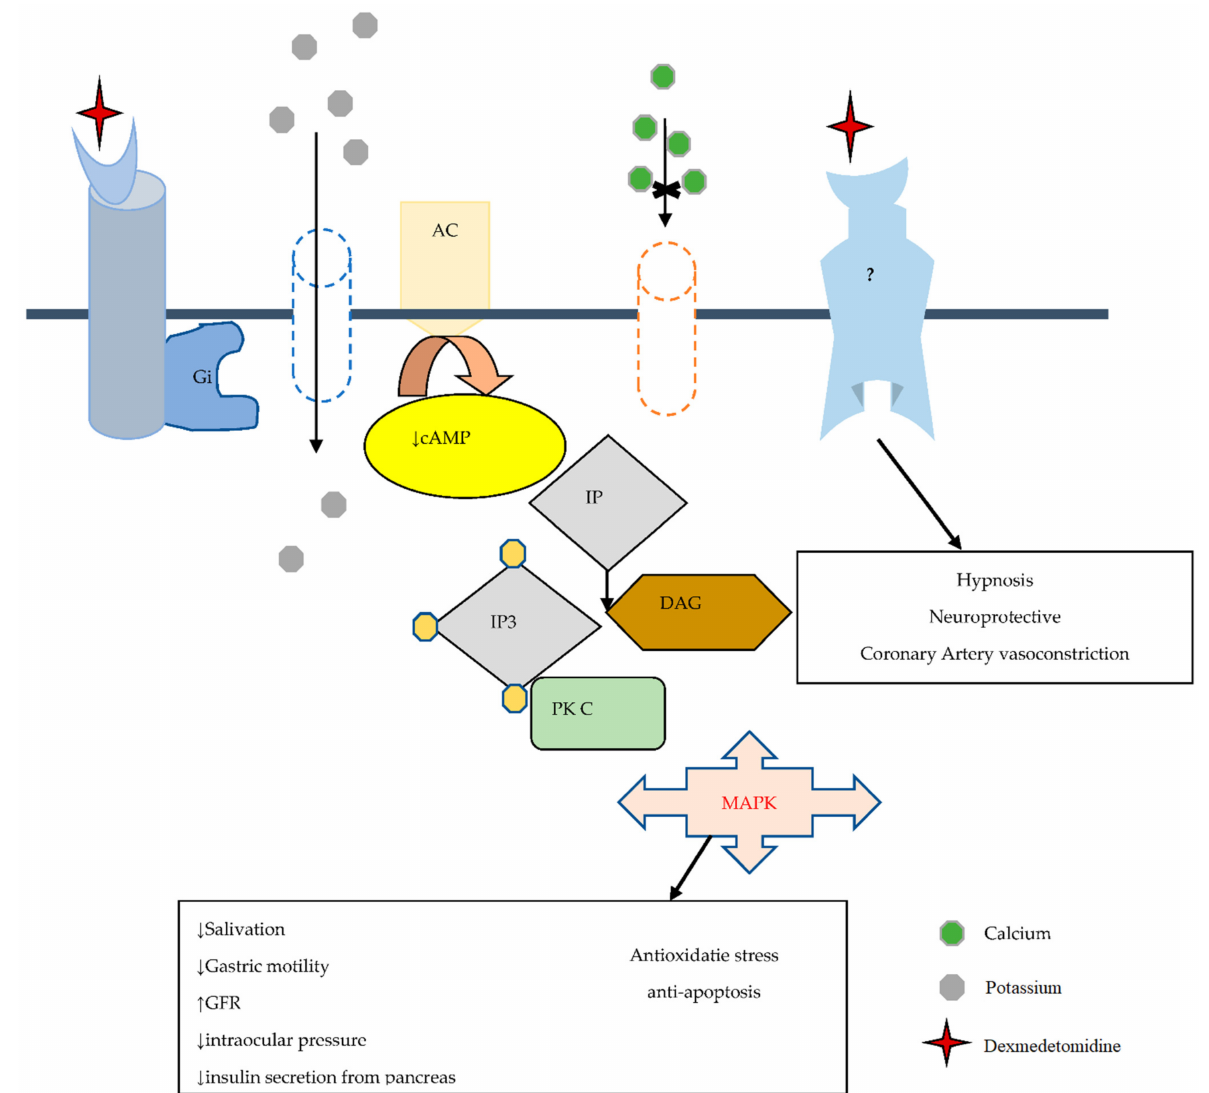
Figure 1. The possible DEXM neuroprotective mechanism is mediated by α 2 adrenoreceptor, which links with heterotrimeric transmembrane G inhibitory protein (Gi), which inactivates Adenyl cyclase (AC). Inactivation of AC attenuates the cAMP level (act as the second messenger). Gi opens inward, rectifying the K+ channel and leading to neuronal membrane hyperpolarization. Normally phosphoinositide (PI)hydrolysis to produce hydrolysis produces inositol 1,4,5-trisphosphate (IP3) and diacylglycerol (DAG) and activates PKC, and has a role in oxidative stress and apoptosis. Agonist agent of α 2 receptor (DEXM) via G0 blocks Ca 2+ translocation and inhibits phospholipase C activity, reducing PKC activity. “ ↑ ” increase and “ ↓ ”